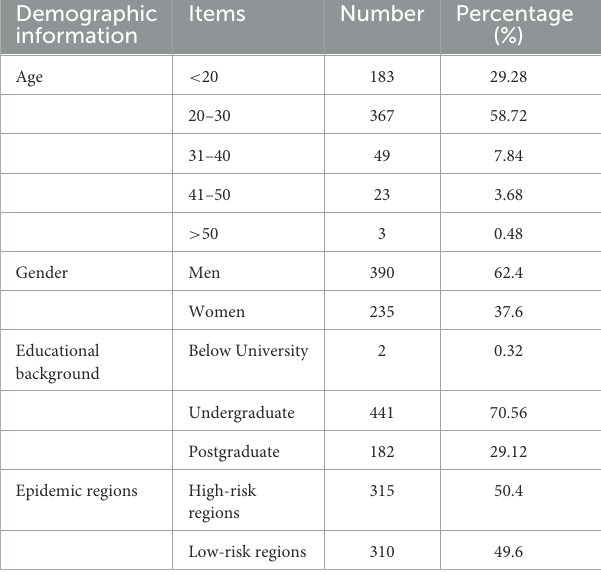
TABLE 3 Basic information about the